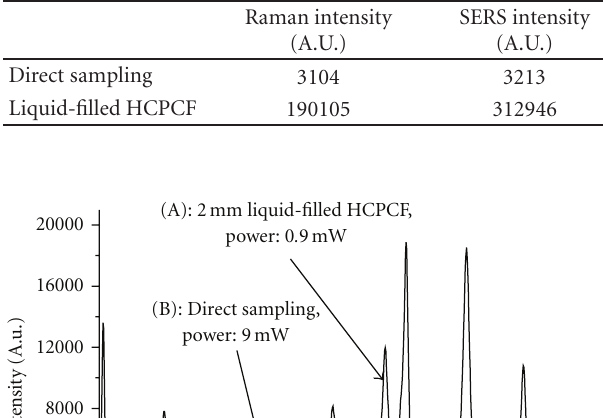
Table 1: Using the 1509 cm − 1 peak as an example, the intensity of the conventional Raman signal and the SERS signal in both the direct sampling and the liquid-filled HCPCF.